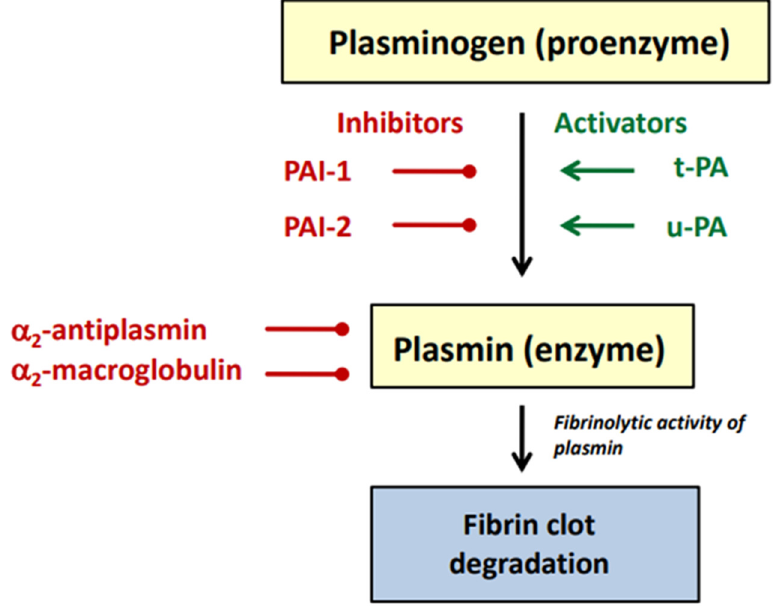
Figure 2. Main components of the fibrinolytic system (description in the text).